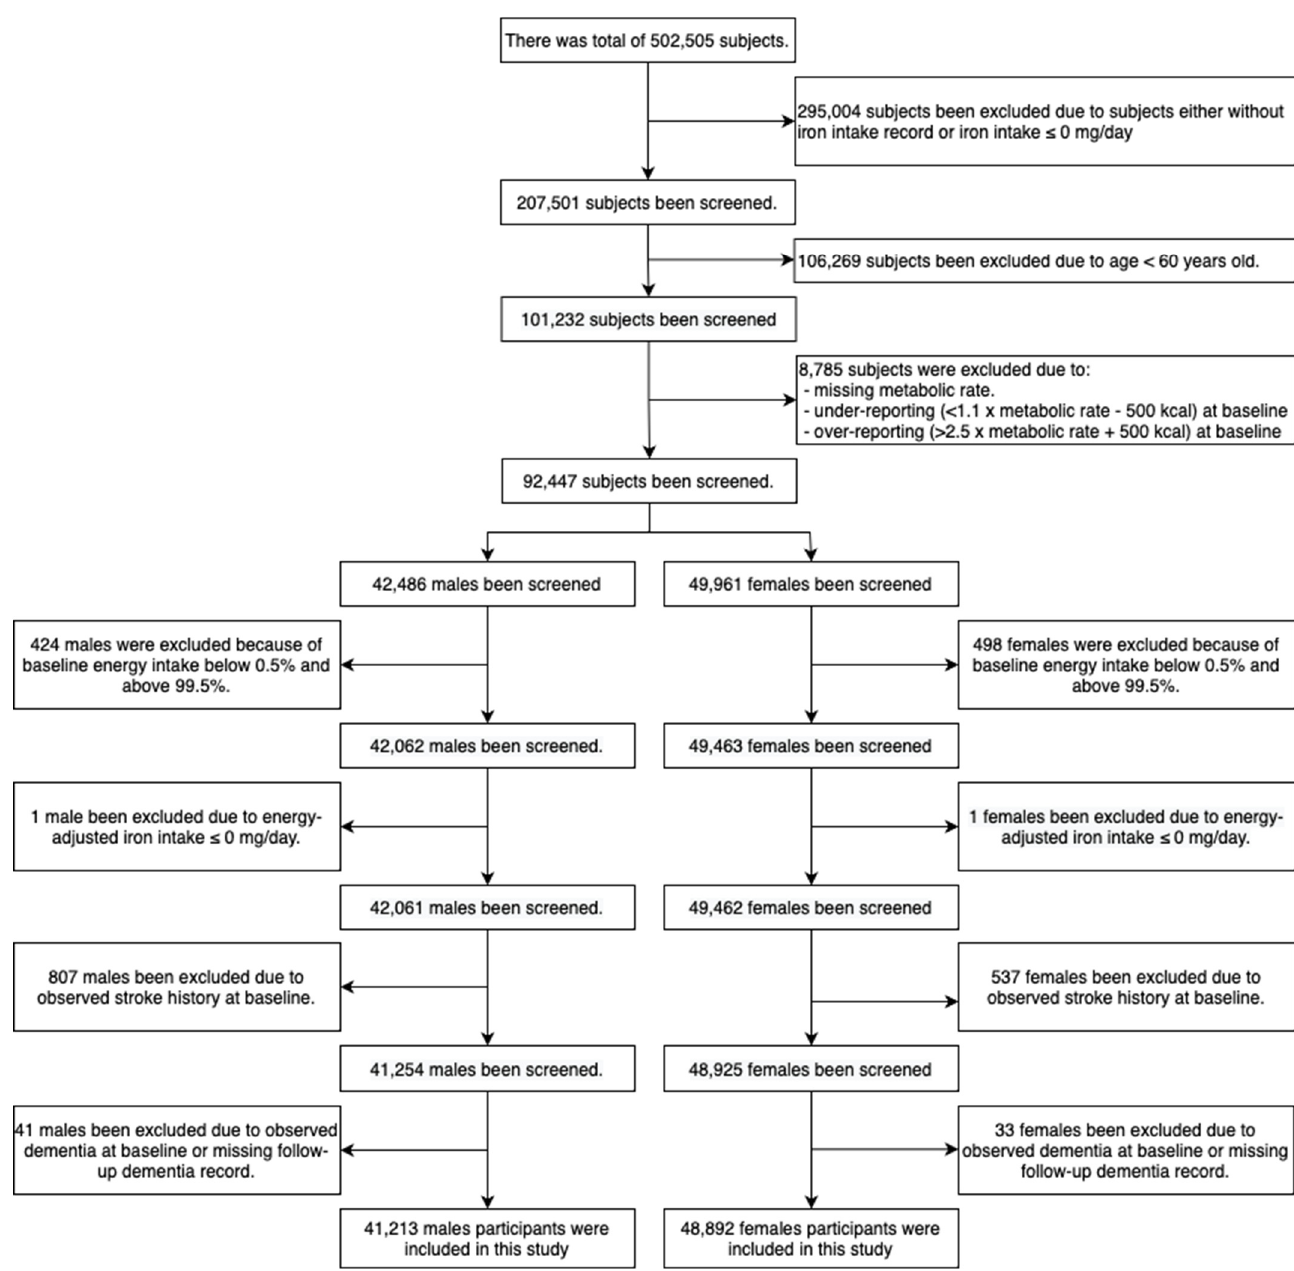
Figure 1. Sample selection